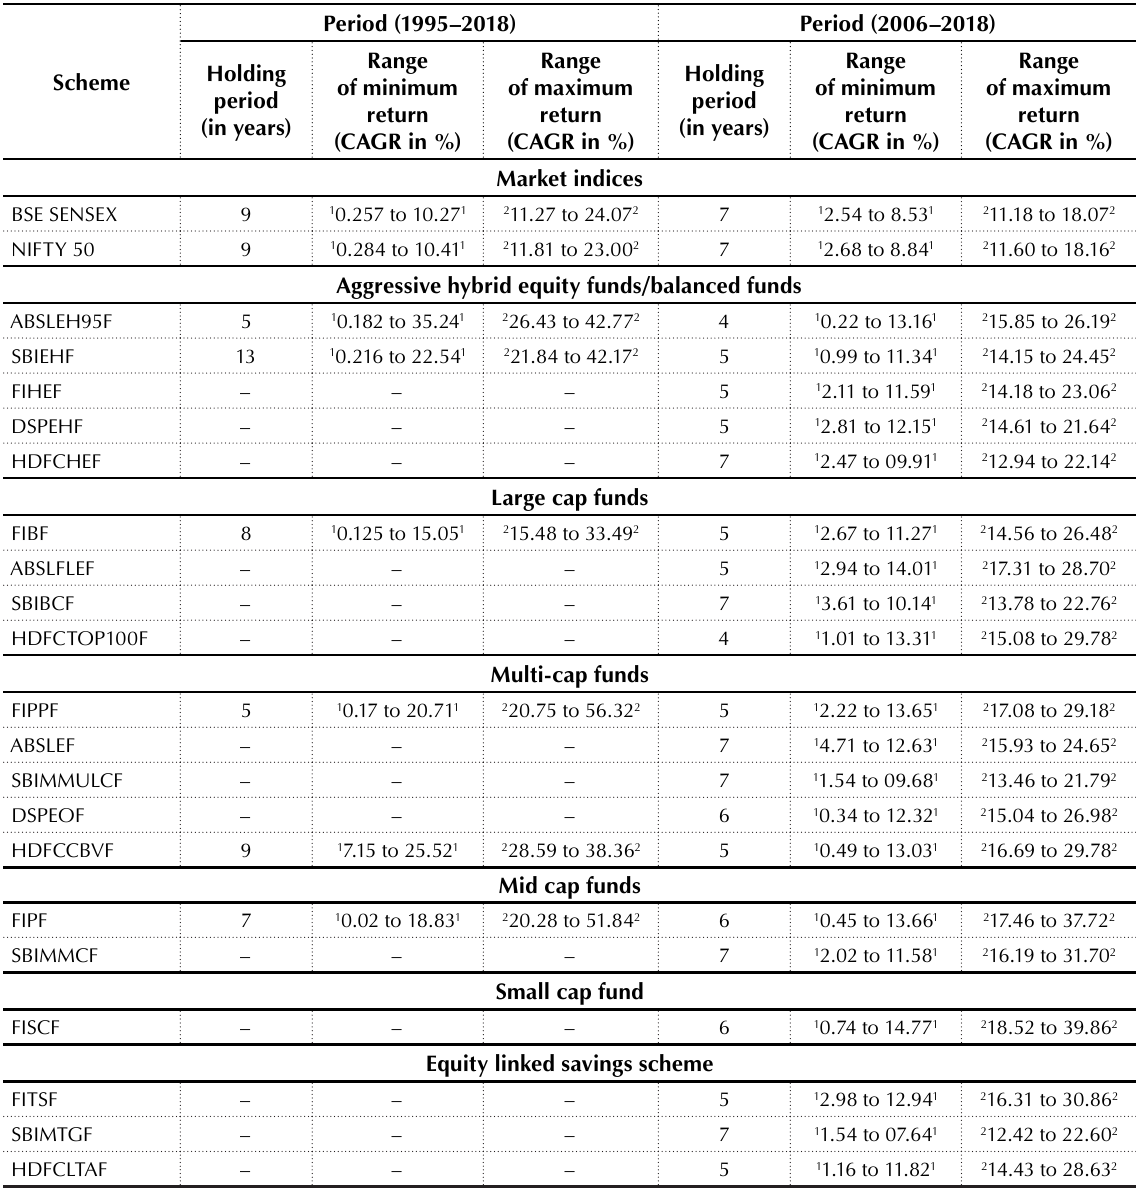
Table 22. Summary of findings of minimum holding period for positive returns across indices and different categories of mutual fund schemes